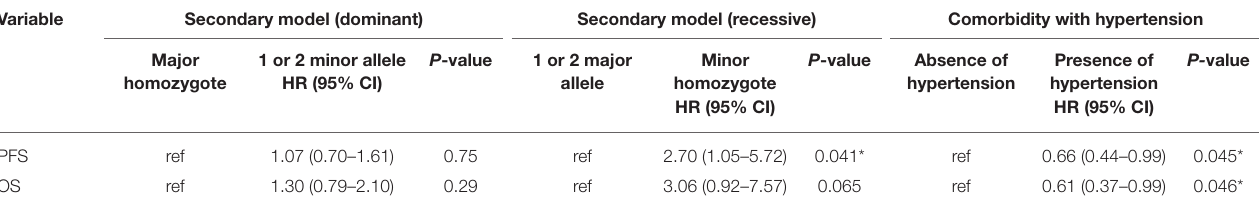
TABLE 2 | PFS and OS among men undergone ADT stratified by MR rs5522 polymorphism, and comorbidity with hypertension. Variable